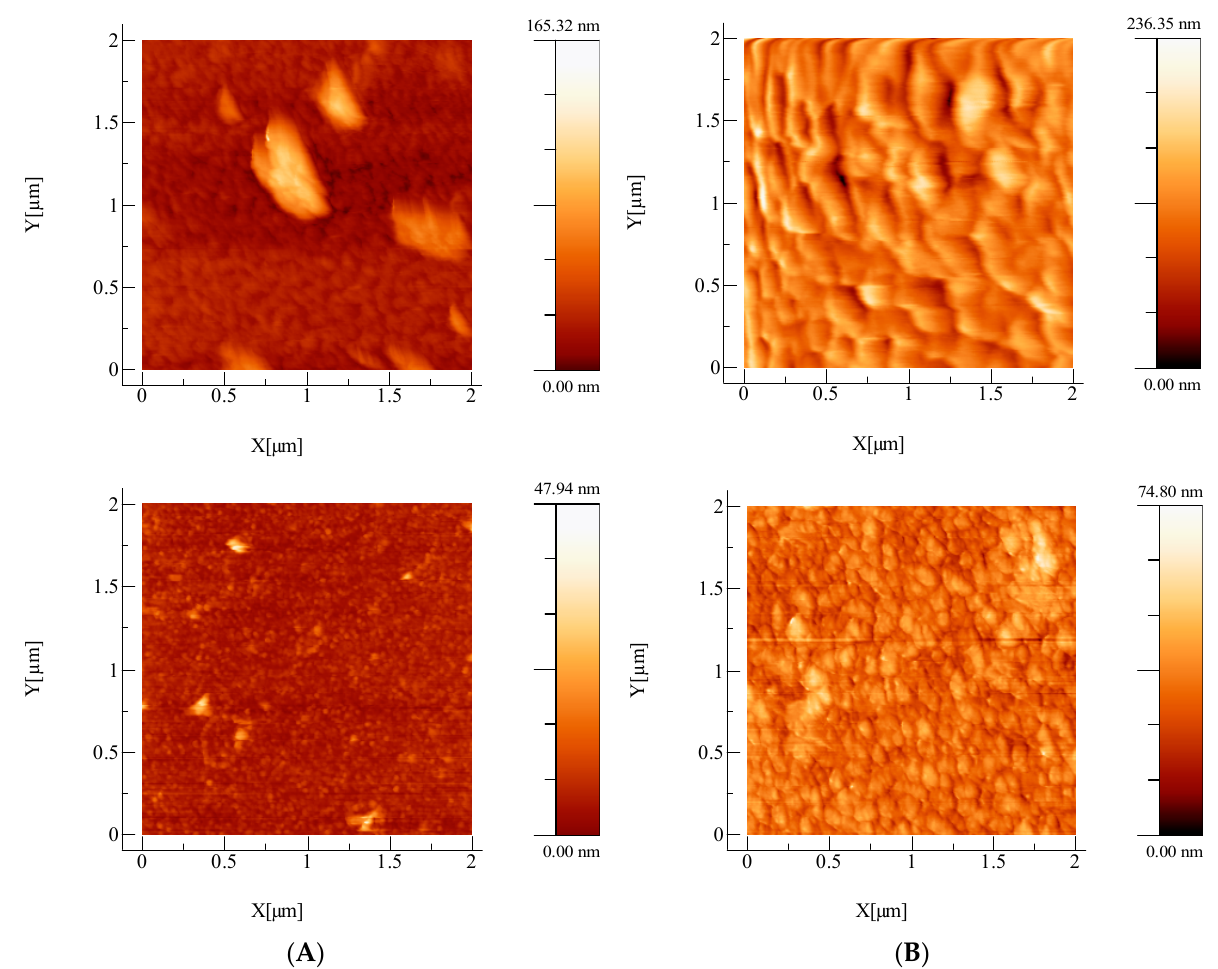
Figure 3. AFM analyses of top surfaces of oxide/Ag/oxide structures deposited on glass ( A ) and on PET ( B ): ( a ) TiO 2 /Ag/TiO 2 , ( b ) TiO 2 :Nb/Ag/TiO 2 :Nb and ( c ) NiO/Ag/NiO.